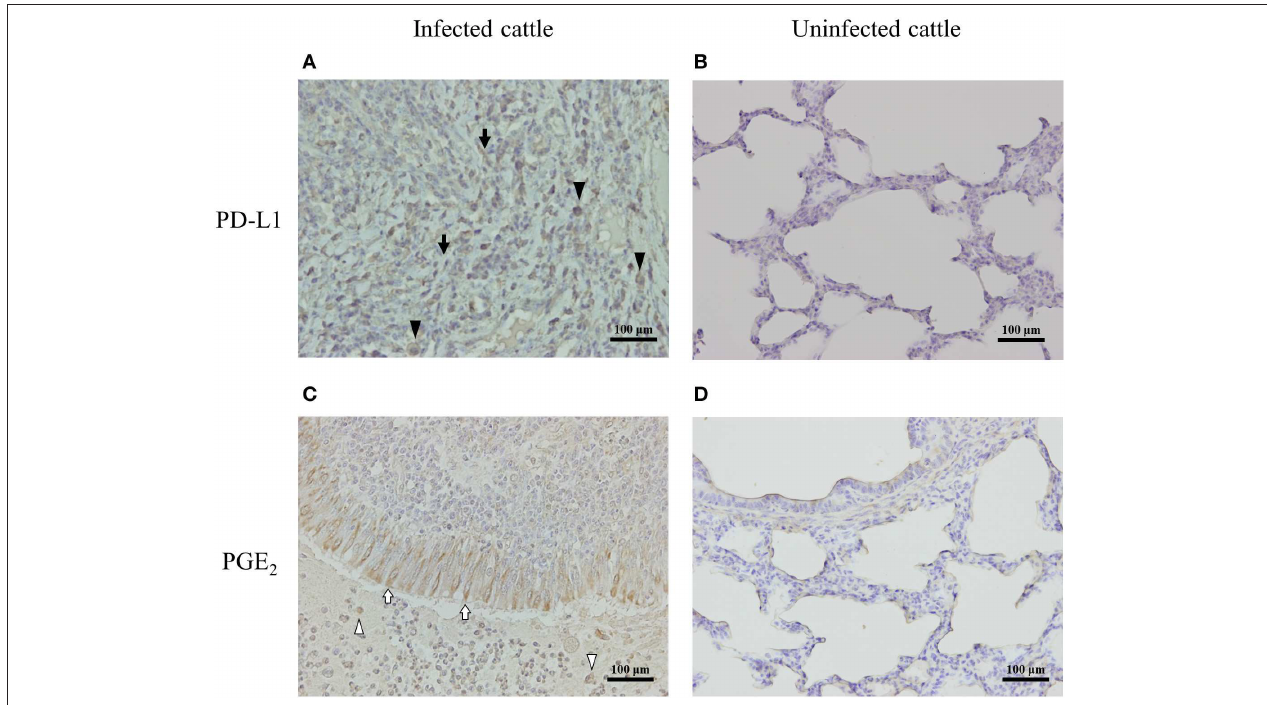
FIGURE 5 | PD-L1 and PGE 2 expression in the lung of M. bovis -infected cattle with pneumonia. Immunohistochemical staining of PD-L1 (A,B) and PGE 2 (C,D) in lung tissues of cattle with or without M. bovis infection was performed using anti-bovine PD-L1 mAb (6C11-3A11) and human PGE 2 polyclonal Ab (rabbit polyclonal). Black arrowheads, PD-L1 positive macrophages; black arrows, PD-L1 positive fibroblasts; white arrowheads, PGE 2 -positive macrophages; white arrows, PGE 2 -positive epithelial